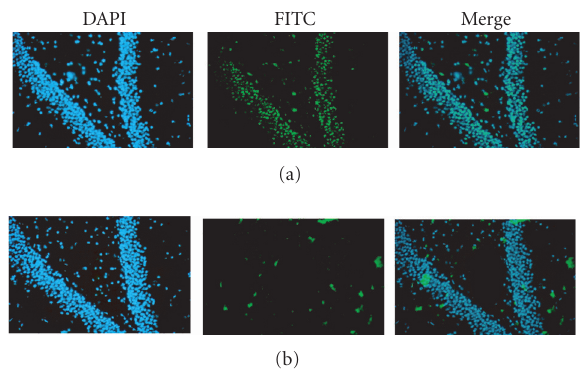
Figure 5: Representative in situ zymography results demonstrating gelatinase activity by MMPs in the dentate gyrus in the presence of (a) PBS (control condition) upper panels or (b) FN-439 (14.4 mM) lower panels. The equivalent blue fluorescence of cell nuclei suggests no cellular toxicity. MMP-2 and MMP-9 activity, visualized as green fluorescence, was significantly inhibited by FN-439 as evidenced by reductions in green